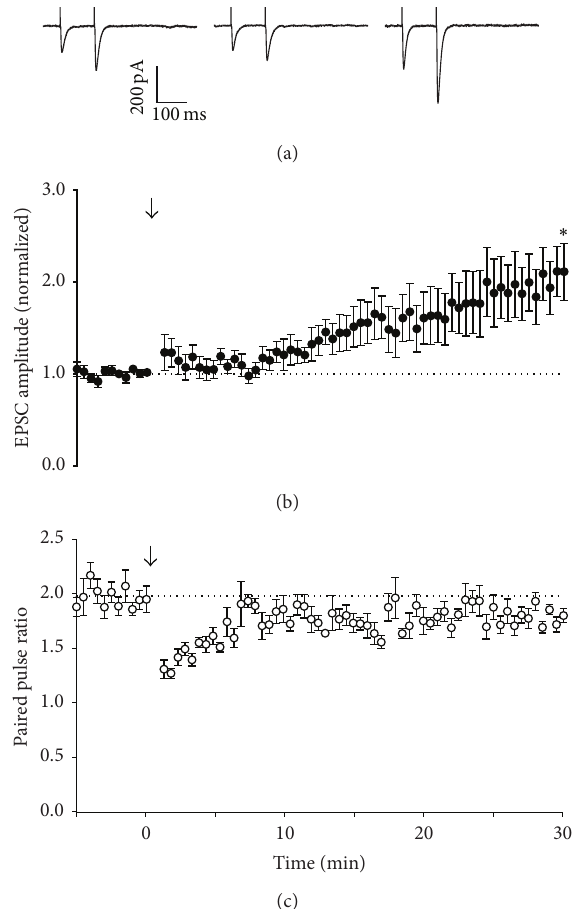
Figure 1: Effect of 16Hz tetanic stimulation on Purkinje neuron responses. (a) Representative whole-cell recordings of neuronal excitatory postsynaptic currents (EPSC) generated by paired pulse stimulation (100ms interval) of parallel fibres in transverse cere- bellar slices at 0.033 Hz before (first panel), immediately after (second panel), and 30 minutes after (third panel) raised frequency stimulation (RFS, 16 Hz, 15 s). (b) Time course of RFS effect on amplitude of the first pulse in each pair, with RFS delivered at 𝑡 = 0 , indicated by the arrow. Data are mean ± s.e.m. from 7 cells. ∗ 𝑃 = 0.0119 , one-sample 𝑡 -test. (c) Time course of RFS effect on paired pulse ratio after tetanic stimulation at 𝑡 = 0 . Data are mean ± s.e.m. from 7